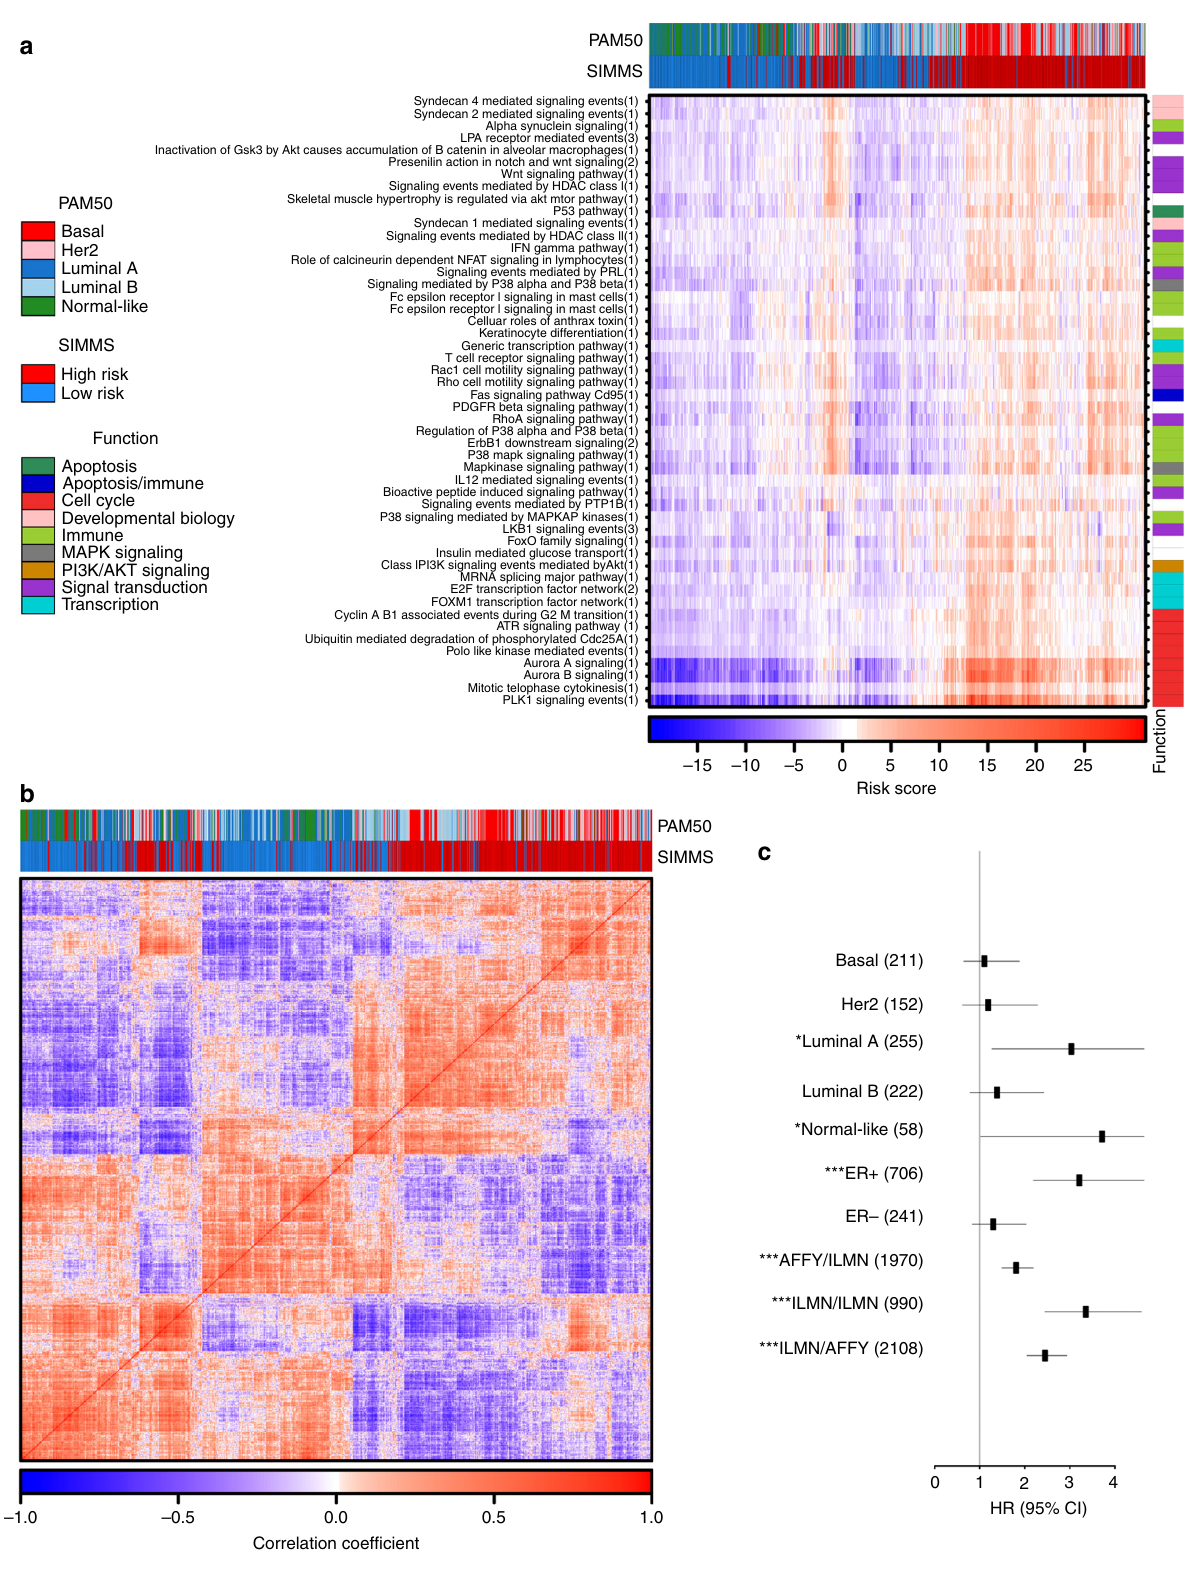
Focusing on breast cancer as a disease with well-de fi ned molecular subtypes, we tested SIMMS on Metabric breast cancer cohort ( n = 1,970) 31 . Our prognostic classi fi er revealed two primary patient clusters with distinct pathway activities encom- passing subnetworks derived from cell cycle, signaling, immune